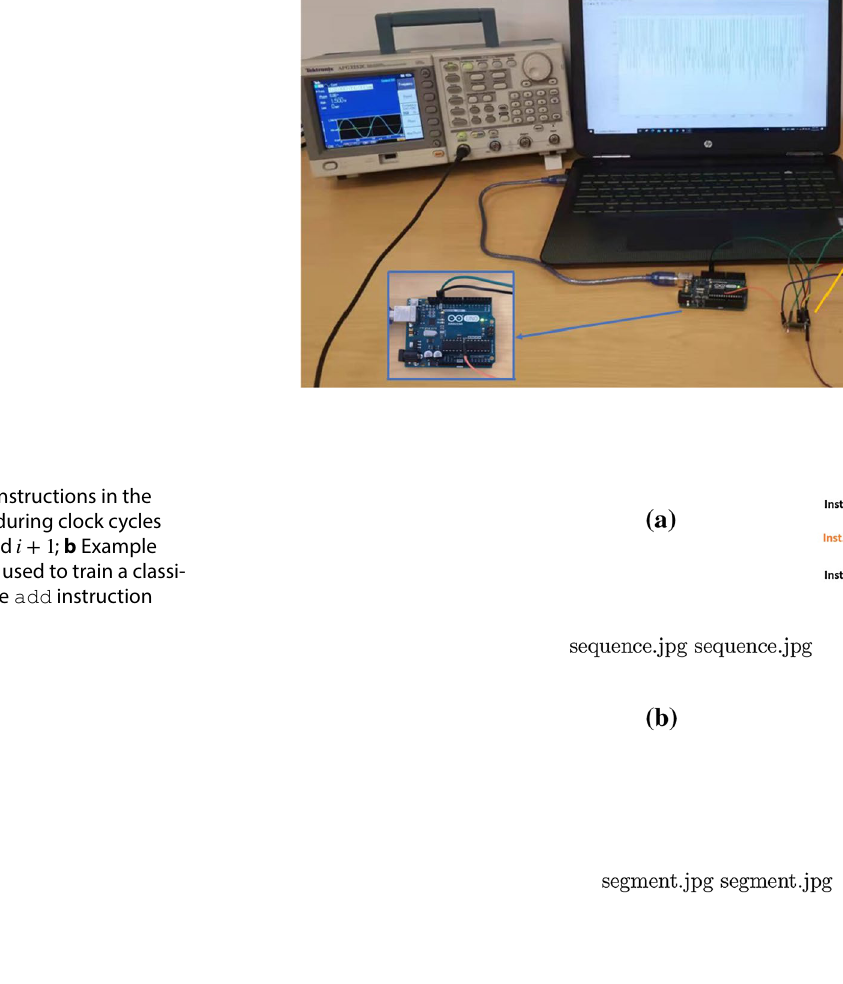
Fig. 5 Experimental setup for collection of power traces from ATmega328P using RASC